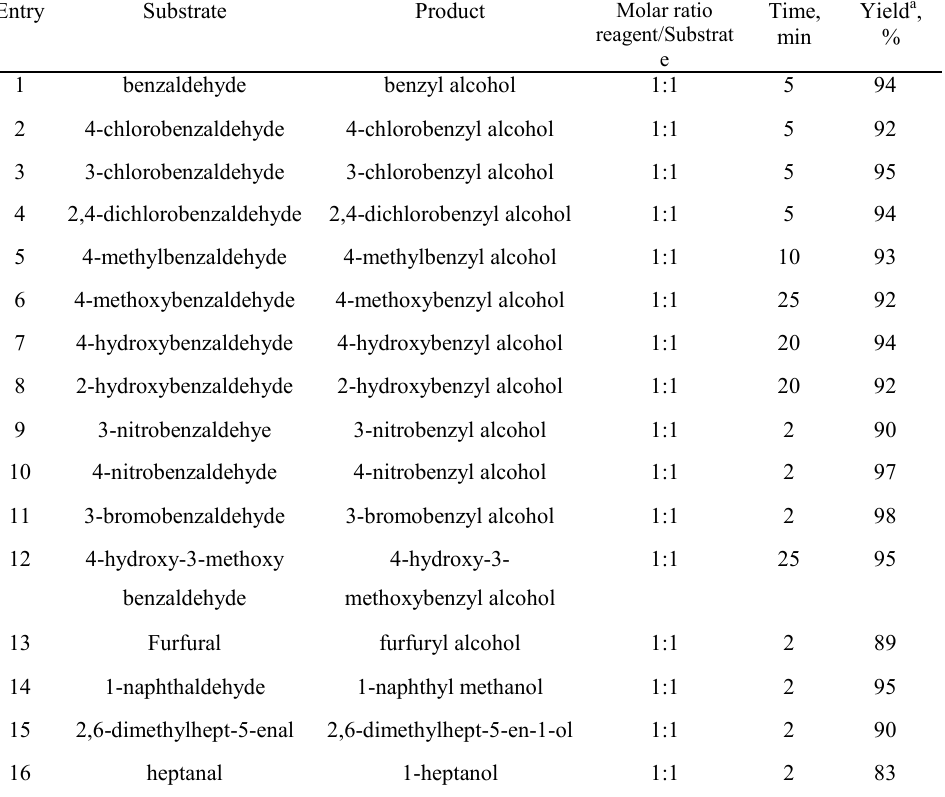
) (nic)] at Room Temperature in CH 4 2